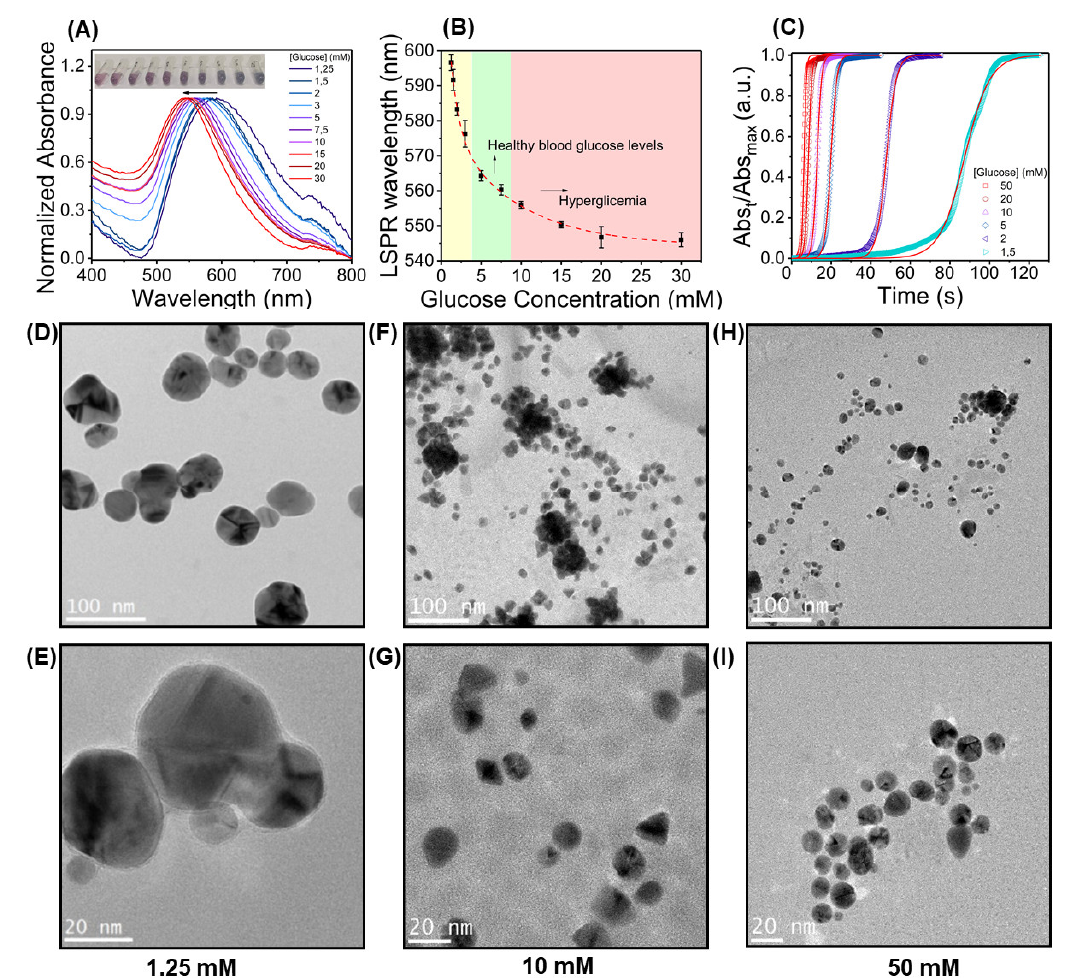
Figure 1. Colorimetric sensing in glucose solutions. ( A ) Colloidal suspensions of gold nanoparticles (AuNPs) produced using different glucose concentrations and corresponding optical spectra. Suspensions have a color evolution from blue (low glucose concentration to red (high glucose concentrations), related to the blue-shift in λ max ; ( B ) plot of λ max vs. glucose concentration for semi-quantitative sensing approach, showing the decrease in λ max with variation in assay sensitivity (n = 3, r 2 = 0.996). ( C ) Kinetic curves with Finke–Watzky model fitting for nucleation and growth, showing that the time for the start of AuNPs growth is prolonged when lower glucose concentrations are applied. TEM data for AuNPs formed at different glucose concentrations. ( D , E ) 1.25 mM; ( F , G ) 10 mM; ( H , I ) 50 mM.